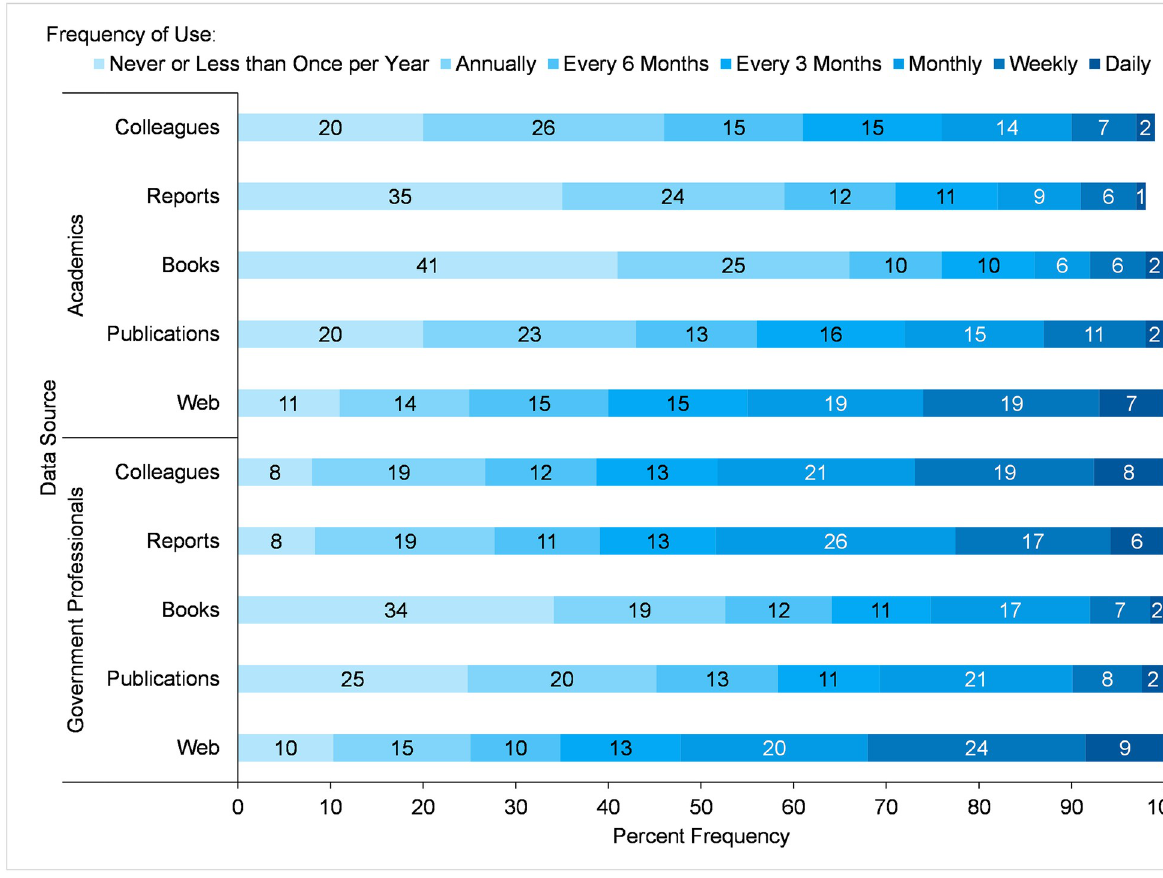
Fig 4. Frequency of use of data sources by academic and government participants who used species occurrence